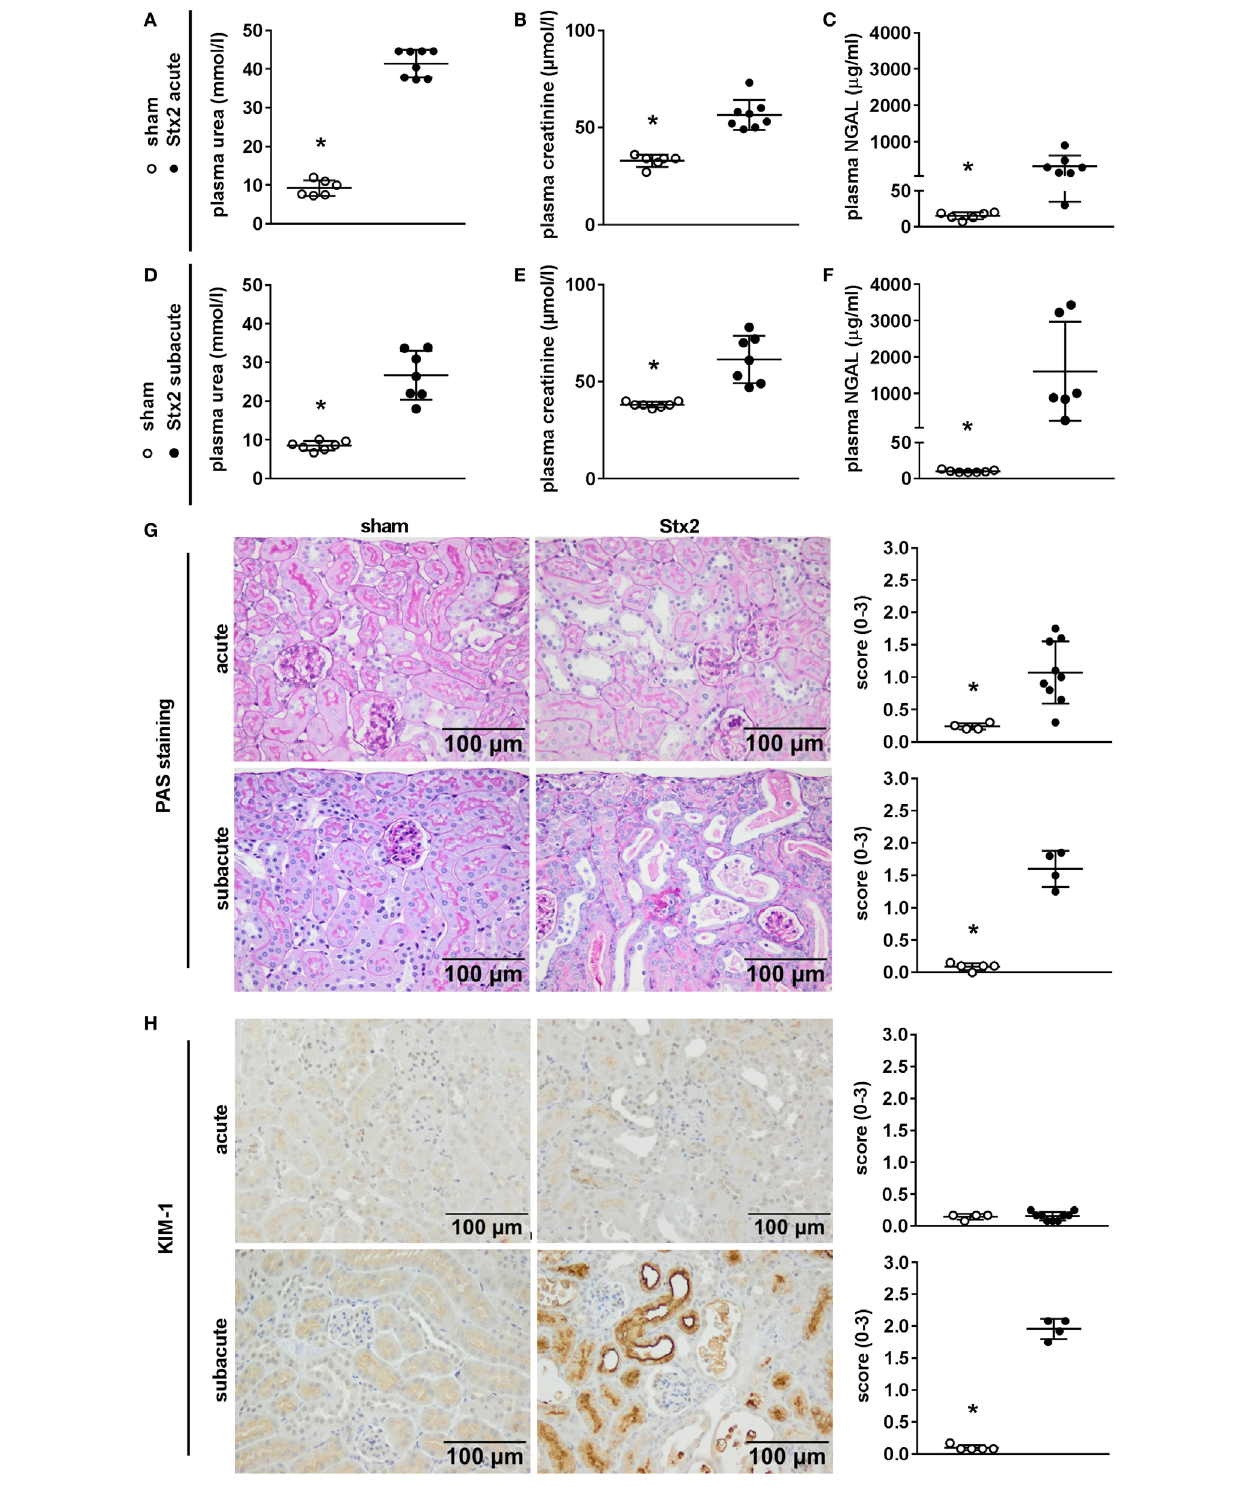
FigUre 6 | Indicators of kidney injury in mice subjected to different Stx2 regimens. (a,D) Plasma urea, (B,e) plasma creatinine, and (c,F) plasma neutrophil gelatinase-associated lipocalin (NGAL) levels were measured for the acute model (sham n = 6, Stx2 n = 8) and subacute model (sham n = 7, Stx2 n = 7, NGAL Stx2 n = 6). Data are expressed as mean ± SD for n observations. * p < 0.05 for sham vs. Stx2 ( t -test). Representative images (scale bar 100 µm) and quantitative data of (g) periodic acid Schiff (PAS) staining and (h) immunohistochemical detection of kidney injury molecule-1 (KIM-1) in renal sections of C57BL/6J wild-type mice are depicted (acute: sham n = 4, Stx2 n = 9; subacute: sham n = 5, Stx2 n = 4). * p < 0.05 for sham (white dots) vs. Stx2 (black dots; Mann–Whitney U -test).